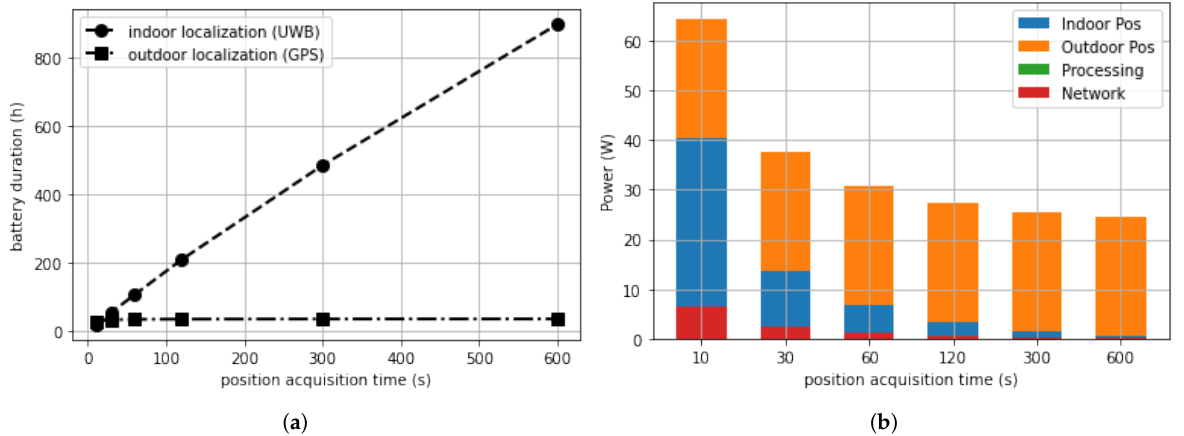
Figure 7. Energy consumption of the main electronic component of the smart badge. ( a ) Battery duration with indoor and outdoor localisation. ( b ) Energy budget breakdown.